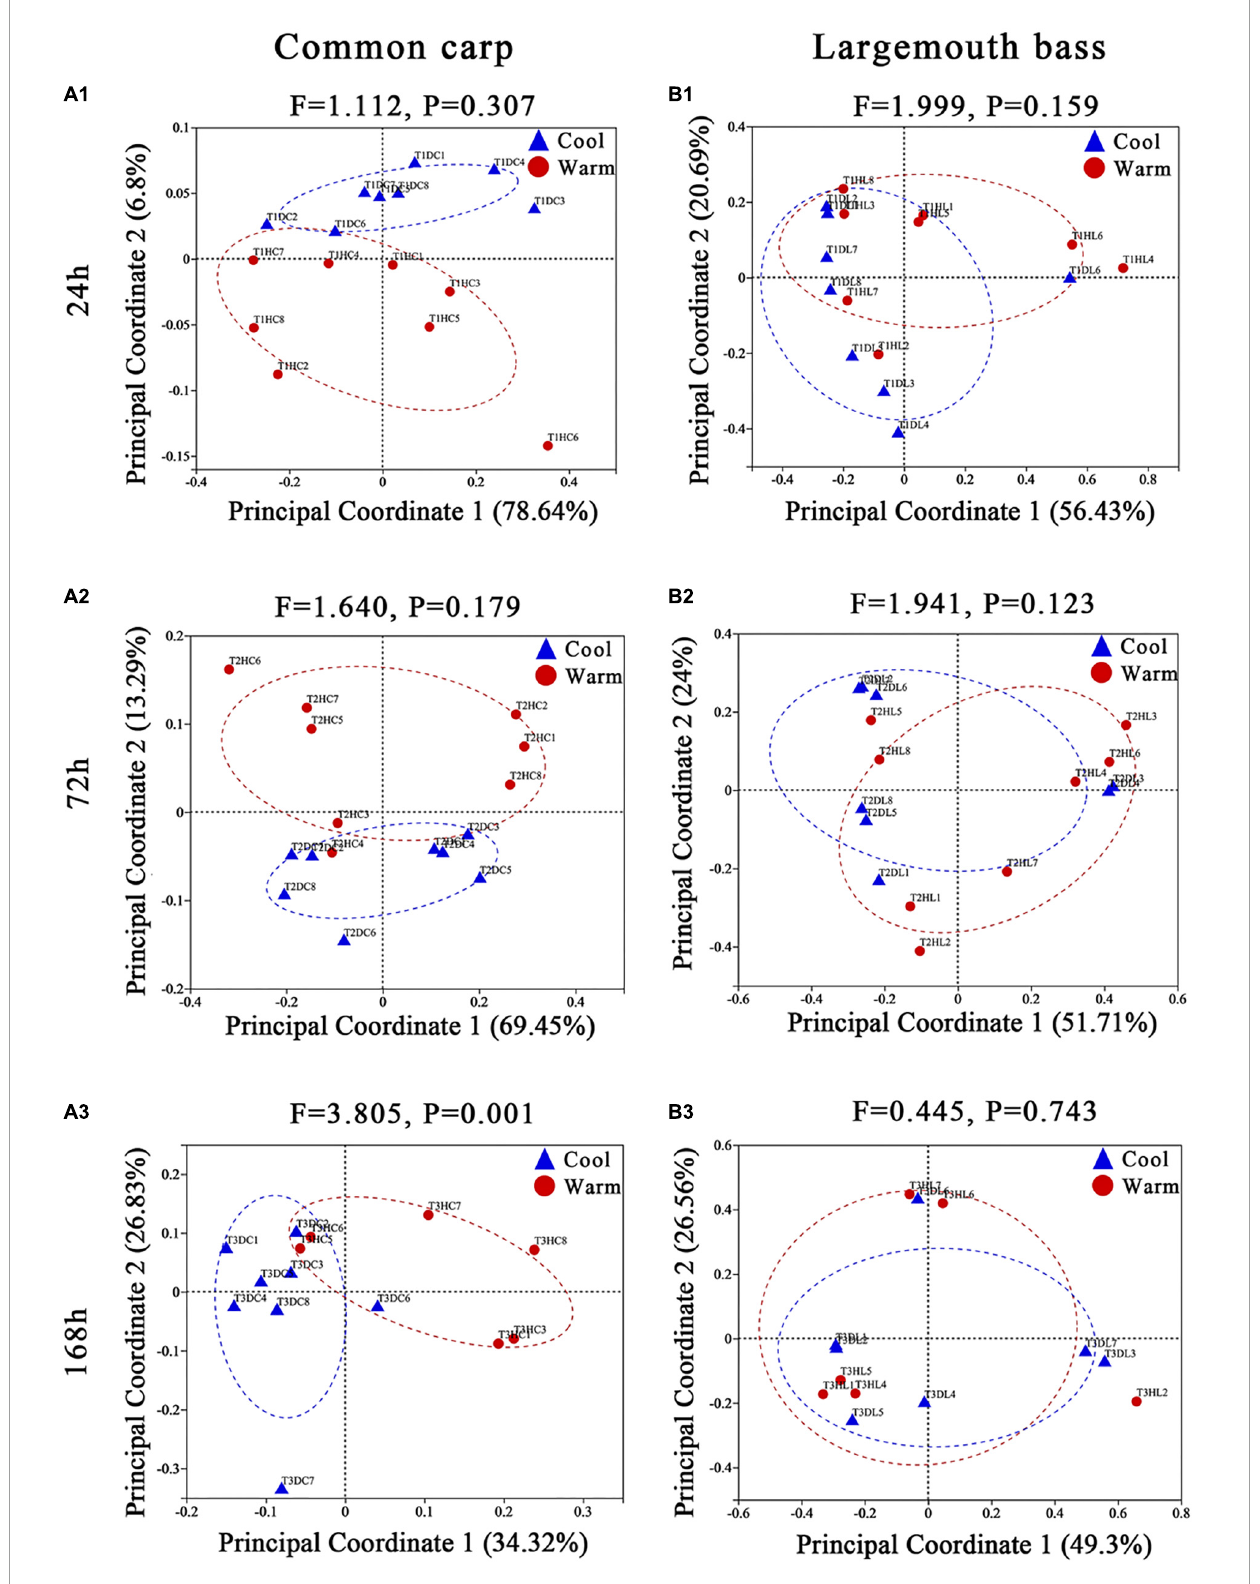
FIGURE1 Principal coordinate analyses plots of common carp and largemouth bass gut microbiota at the 24 h (A1,B1) , 72 h (A2,B2) , and 168 h (A3,B3) experimental time points, based on weighted UniFrac distance across samples. Points are colored by temperature treatment (red = warm; blue = cool), and ellipses represent the 95% confidence interval of that treatment group. On each plot, the results of PERMANOVA models assessing the temperature effects on gut microbial community composition at that time point are displayed, including the F statistic from the model, and the FDR corrected p -values ( q -value). Percentages on the axes of PCoA plots indicate the proportion of variation explained by that